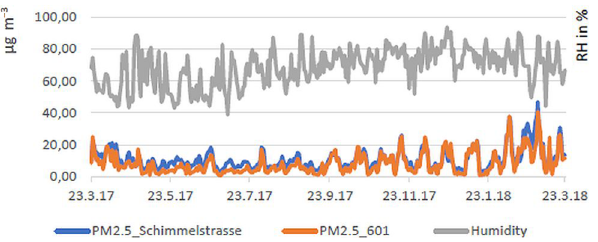
Figure 8. Daily average PM and relative-humidity values for Schimmelstrasse.